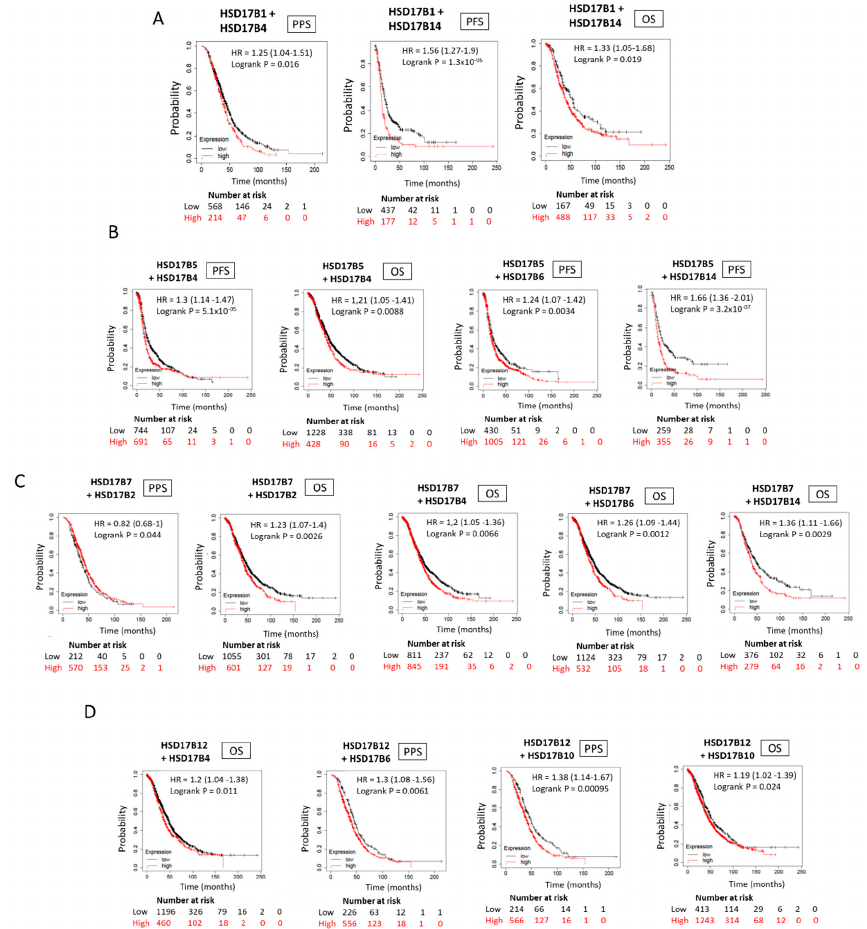
Figure 8. Ovarian cancer patient outcome based on combined low and high expression of E2- and E1-synthetizing HSD17B enzymes, respectively. ( A – D ) Kaplan–Meier curves comparing the correlation between low intratumoural expression levels of the E2-synthetizing enzymes HSD17B1 ( A ), HSD17B5 ( B ), HSD17B7 ( C ) and HSD17B12 ( D ); combined with high intratumorual expression of the different E1-synthetizing HSD17B isoforms indicated, including HSD17B2, HSD17B4, HSD17B6, HSD17B10 and HSD17B14; and PPS, PFS and OS in ovarian cancer patients.